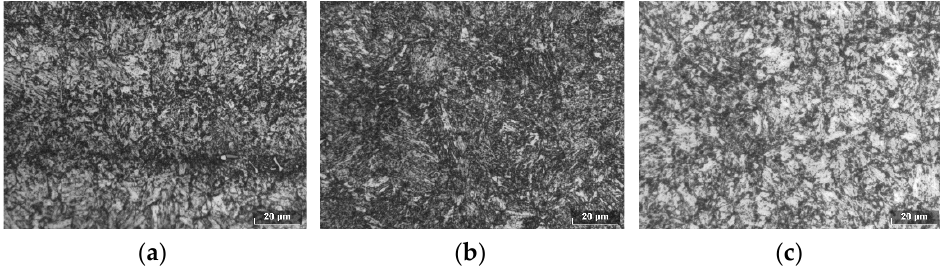
Figure 14. Microstructure in inner wall ( a ), central part ( b ) and outer wall ( c ) of CT.